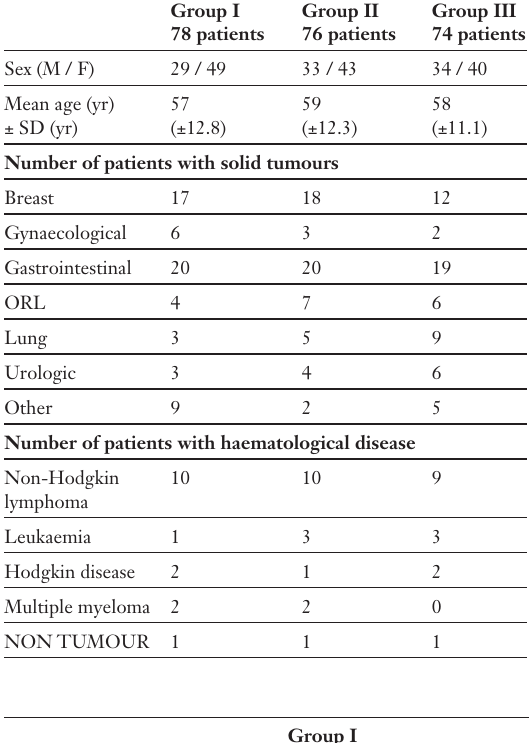
Technical specifica- tions of the